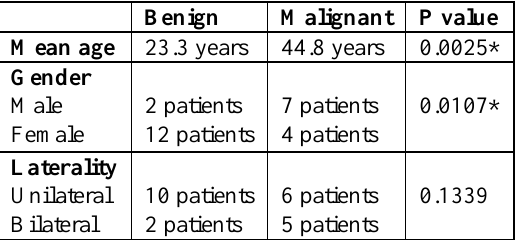
Table 1: Summary of the characteristics of